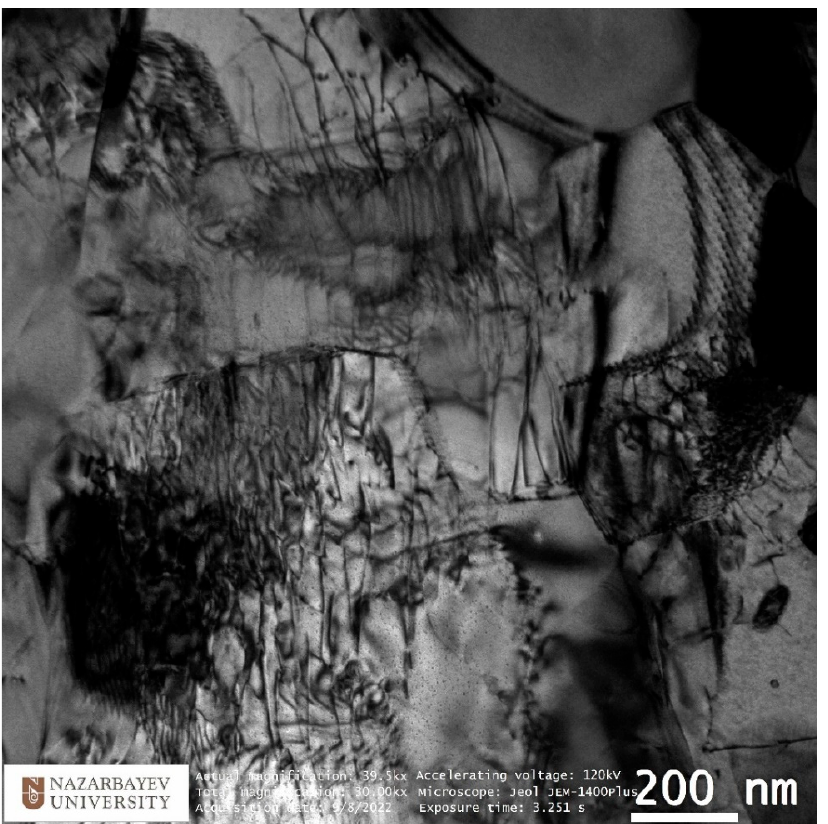
Figure 13. TEM-characterization of final sample peripheral fine structure peculiarities.